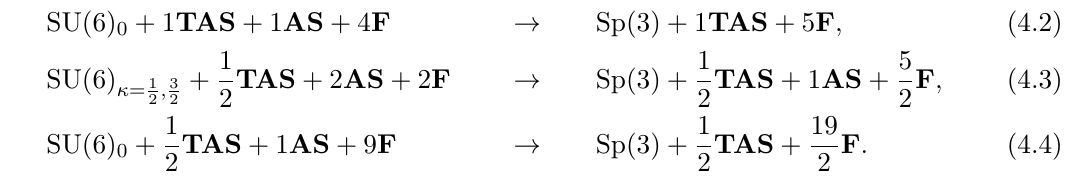
+ 1 TAS + 1 Sym diagram with both O7 (cid:0) - and O7 + (cid:0) 3 2 2